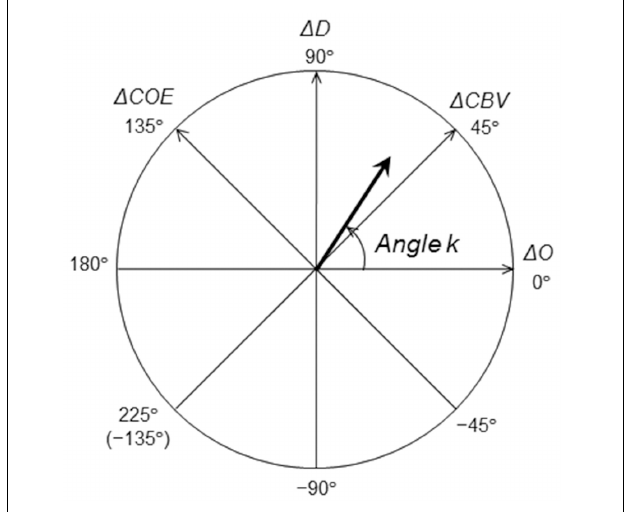
FIGURE 3 | Definition of the vector coordinates. Polar coordinate plane for the analysis of cerebral oxygenation and blood volume. The relationship